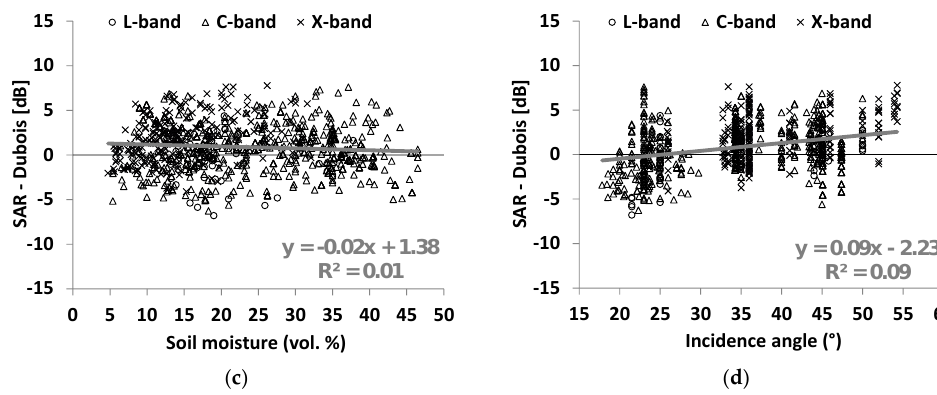
Figure 2. For VV polarization, ( a ) comparison between radar backscattering coefficients calculated from SAR images and estimated from the Dubois model; ( b ) the difference between the SAR signal and the Dubois model relative to soil roughness ( kHrms ); ( c ) the difference between the SAR signal and the Dubois model relative to soil moisture ( mv ); and ( d ) the difference between the SAR signal and the Dubois model relative to incidence angle. The best regression model is plotted in gray.